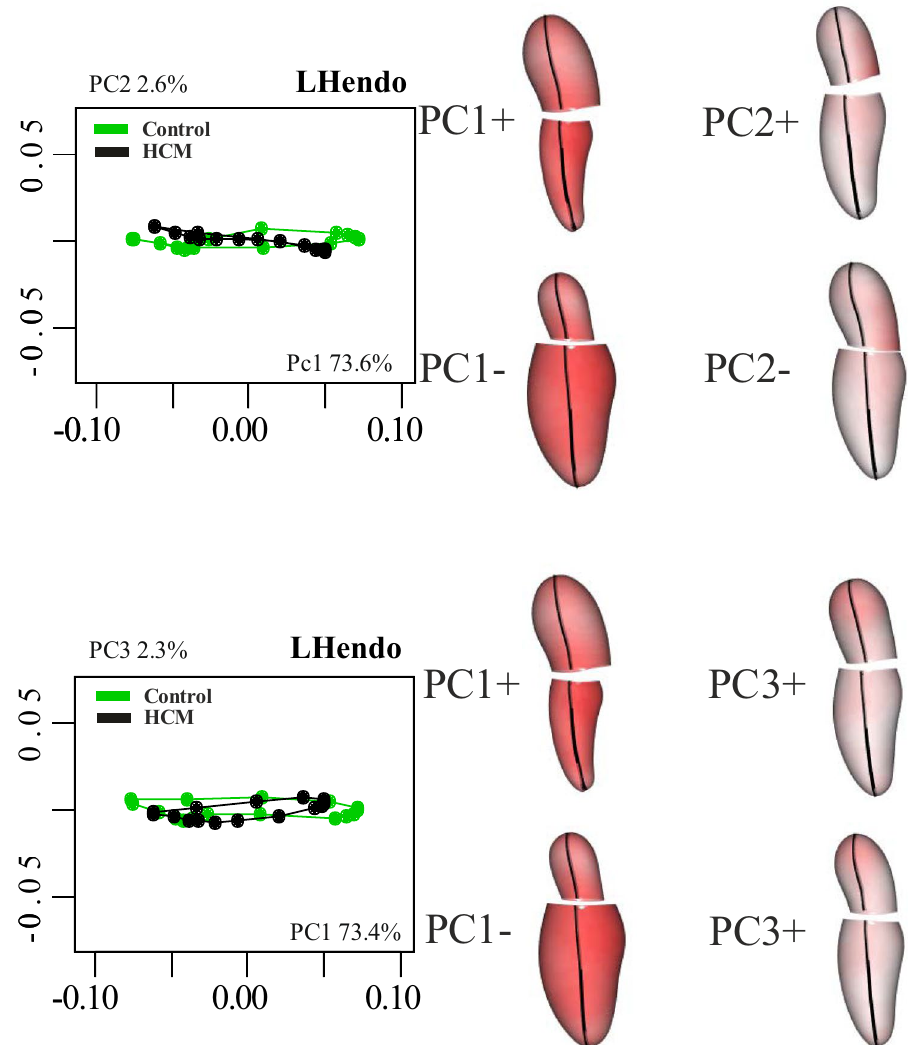
Figure 2. PCA on shapes after Parallel Transport. Centering deformations on GM (differently from what visualized in Fig. 1) allows to consider both systole and diastole as deformed states. Deformations relative to the GM are depicted. The colormap ranges from white (min) to red (max) and refers to |x M − x|, with x M the position of a point in the GM and x its position at the specified PC axis extreme (positive or negative). The first three PCs are shown. Explained variances (in percentage) are also